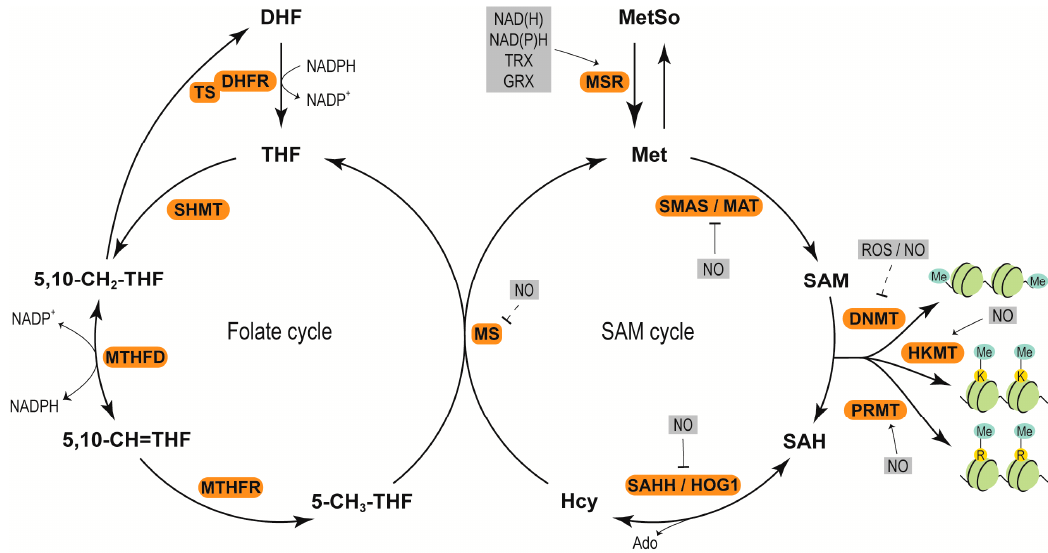
Figure 1. Redox components modulate SAM synthesis through folate cycle in plants. Folate cycle begins with the conversion of DHF to THF through DHFR by utilizing the reducing equivalents from NADPH. Methyls derived from THFs (5,10-CH2-THF, 5,10-CH=THF) are synthesized by SHMT and MTHFD, respectively. 5,10-CH=THF is reduced to 5-CH3-THF by MTHFR. The methyl group from 5-CH3-THF is transferred to Hcy to synthesize Met through MS. The produced Met generates SAM through SAMS. SAM donates methyl groups to DNA or proteins through DNA methyltransferase (DNMT)/HKMT/PRMT, and gets converted to SAH. SAH is further processed to Hcy through SAHH/HOG1. The key enzymes influenced by the cellular redox components are: SAMS/MAT, DNMT/HKMT/PRMT, SAHH/HOG1, MS and MSR. K: lysine; R: arginine; Me: methyl. Dashed lines mean uncharacterized regulation.